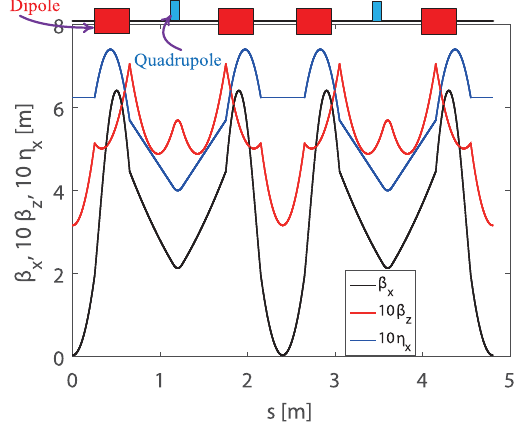
FIG. 6. Betatron amplitude and dispersion functions of a 4.8 m ring, which is used to study the third-order coupling resonance − 2 ν l . at ν x z ¼